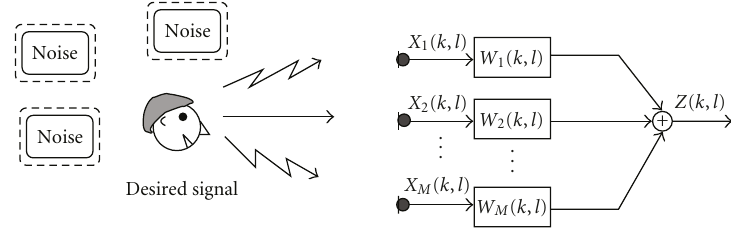
Figure 1: Multi-channel noise reduction set-up in an environment with one or more noise sources and a desired speaker.